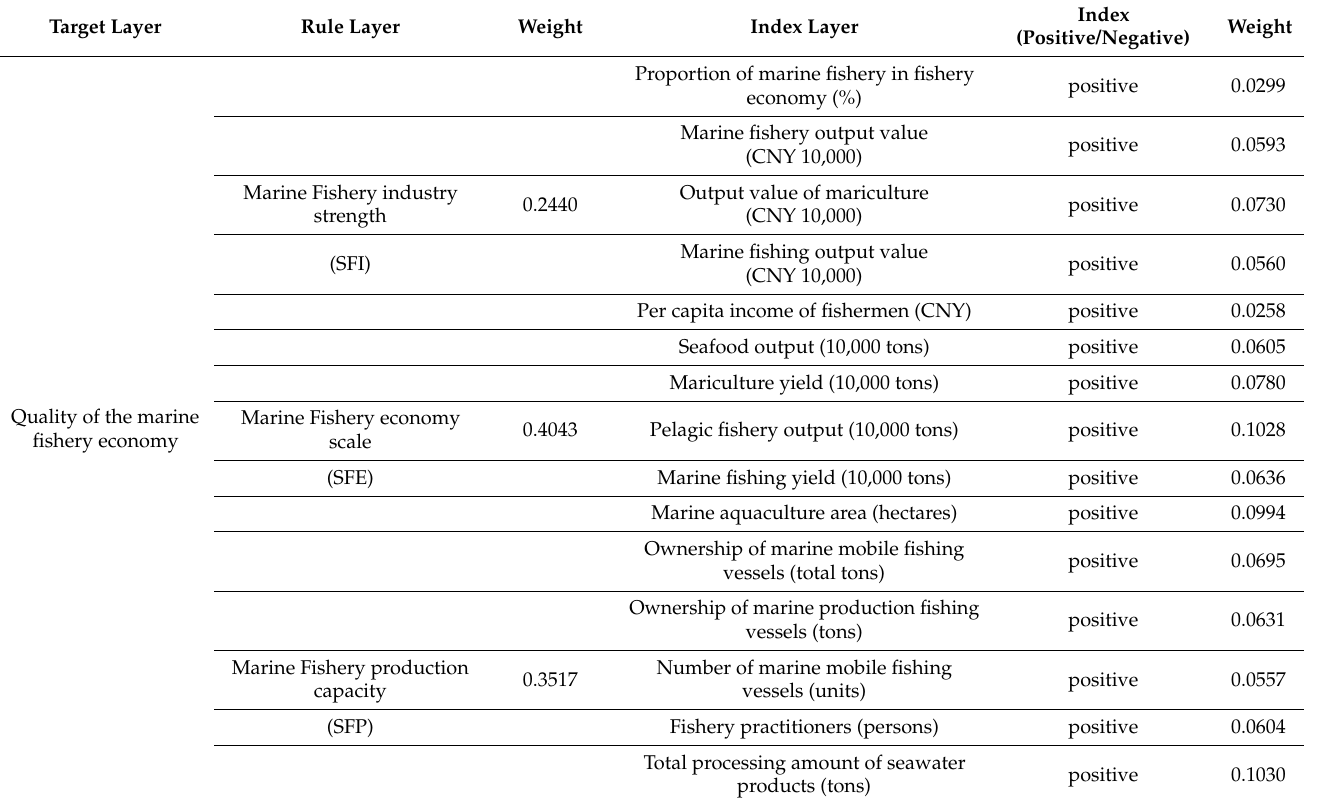
Table 1. Evaluation index system of marine-environment quality and marine-fishery-economy quality. Target